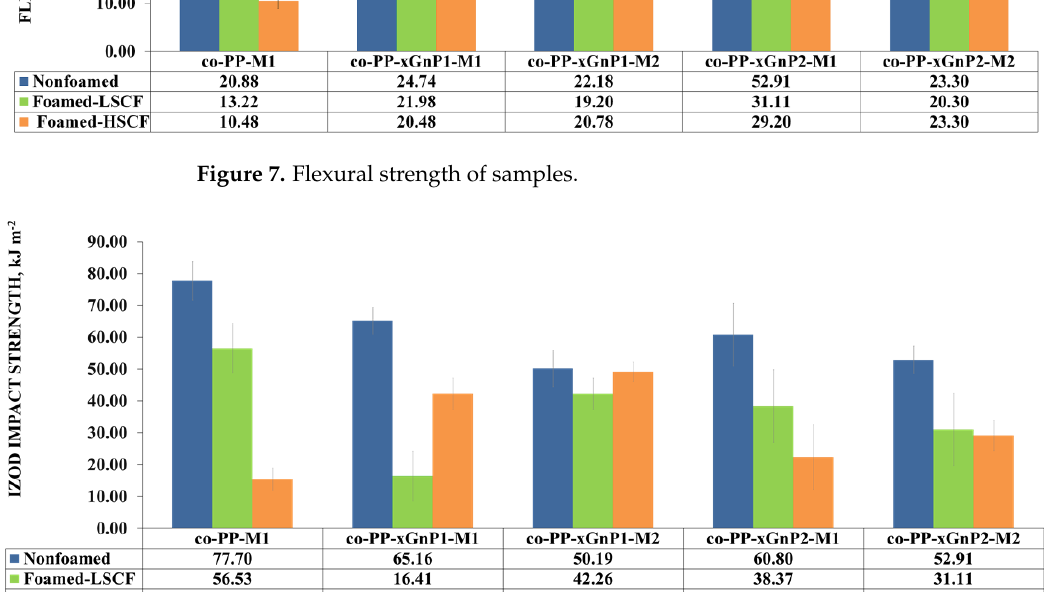
Figure 7. Flexural strength of samples. Figure 8. Izod impact strength of